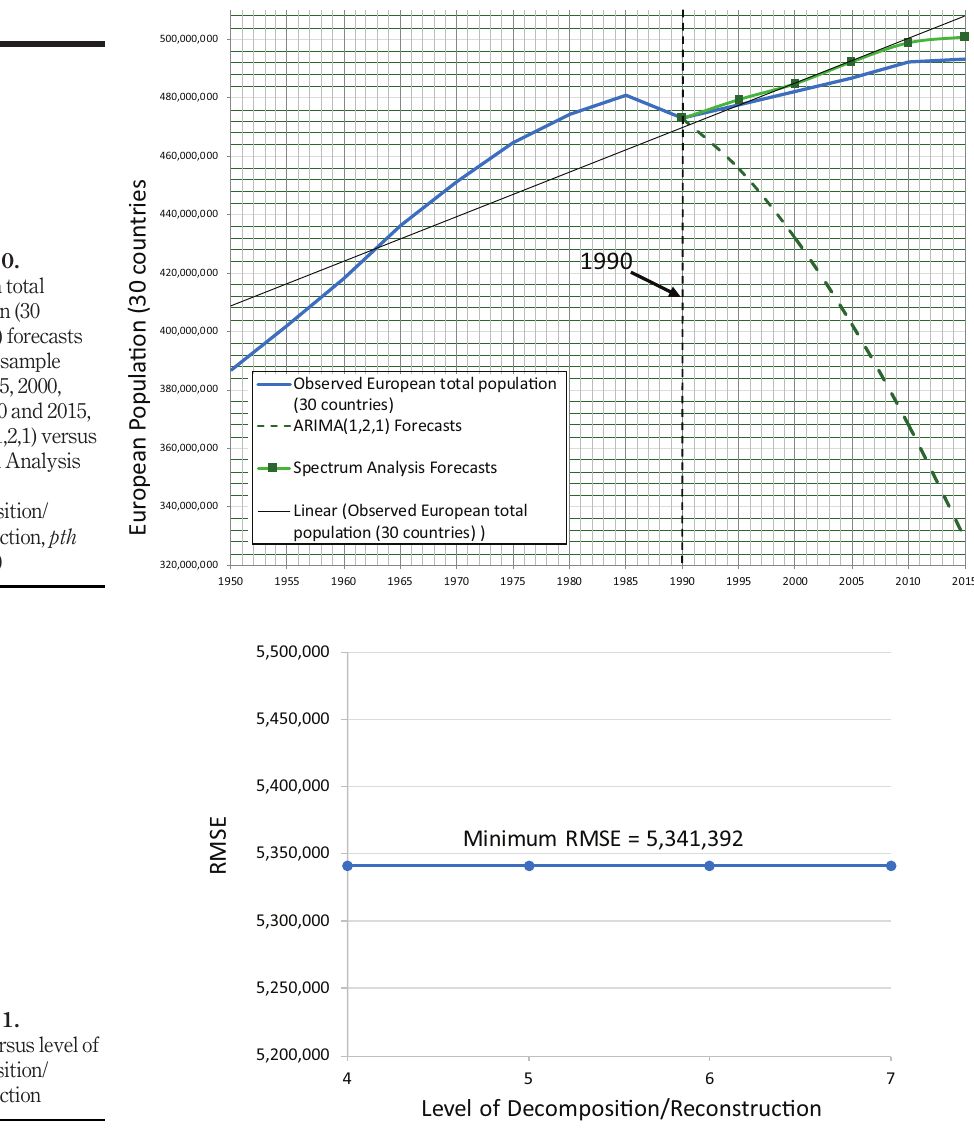
Figure 11. RMSE versus level of decomposition/ reconstruction